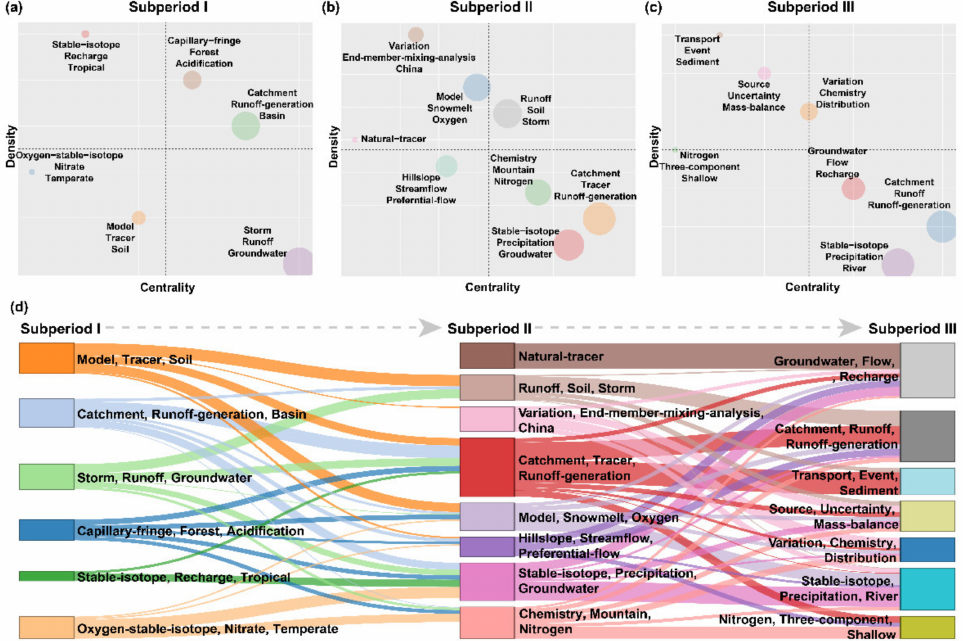
Figure 4. Thematic maps (strategic diagrams: a – c ) and evolution (Sankey graph: d ) of IHS. ( a – c ): The circle size is proportional to the total frequency of terms in each theme. Each theme is labeled with the corresponding three most frequent keywords; ( d ): Each theme is labeled with the corresponding three most frequent keywords. The thickness of the edges is proportional to the inclusion